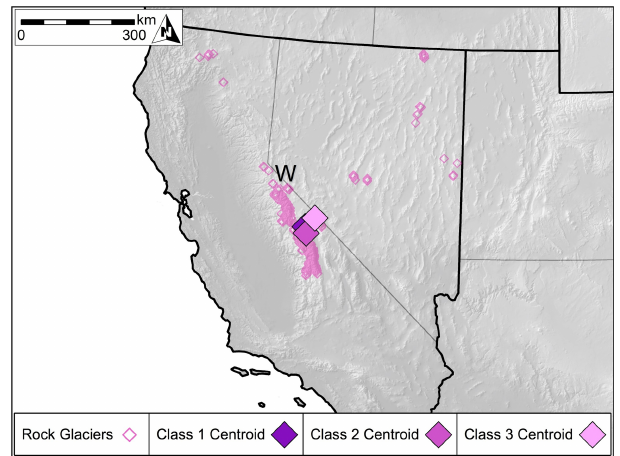
Figure 8. Locations of W Region rock glacier inventory features ( n = 817), as well as centroids for Class 1 ( n = 552), Class 2 ( n = 181), and Class 3 ( n = 84) features. Rock glaciers of the W Region are largest and most densely concentrated in the Sierra Nevada of California.